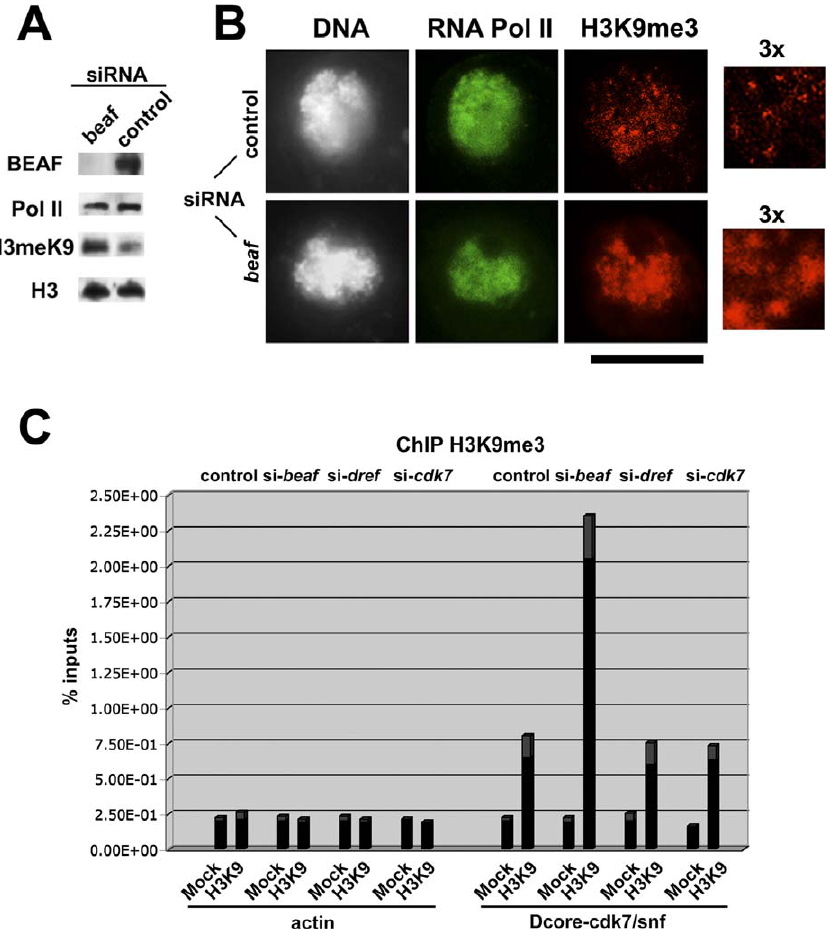
Figure 6. BEAF Restricts the Deposition of H3K9me3 Marks in Dual-Cores (A,B) Western blot (A) and immunostaining (B) analysis with the indicated antibodies of chromatin-associated proteins in BEAF-depleted or control cells. Enlargements of confocal images are also shown (3 3 ). Bar, 10 l m. (C) Quantitative PCR analysis following ChIP with mock control or with anti-H3K9me3 (‘H3K9’) antibodies in control (left), BEAF-depleted (second from left), DREF-depleted (second from right), or CDK7-depleted (right) cells. The graph shows the analysis of the actin control region and of dual-core_38D associated with cdk7-snf . Note that similar results were obtained for the dual-cores associated with mei-S332 (unpublished data). The y -axis shows the percentage of material precipitated from inputs (see Materials and Methods for details). Experimental error is denoted by the differentially colored (gray) portion at the top of each bar.